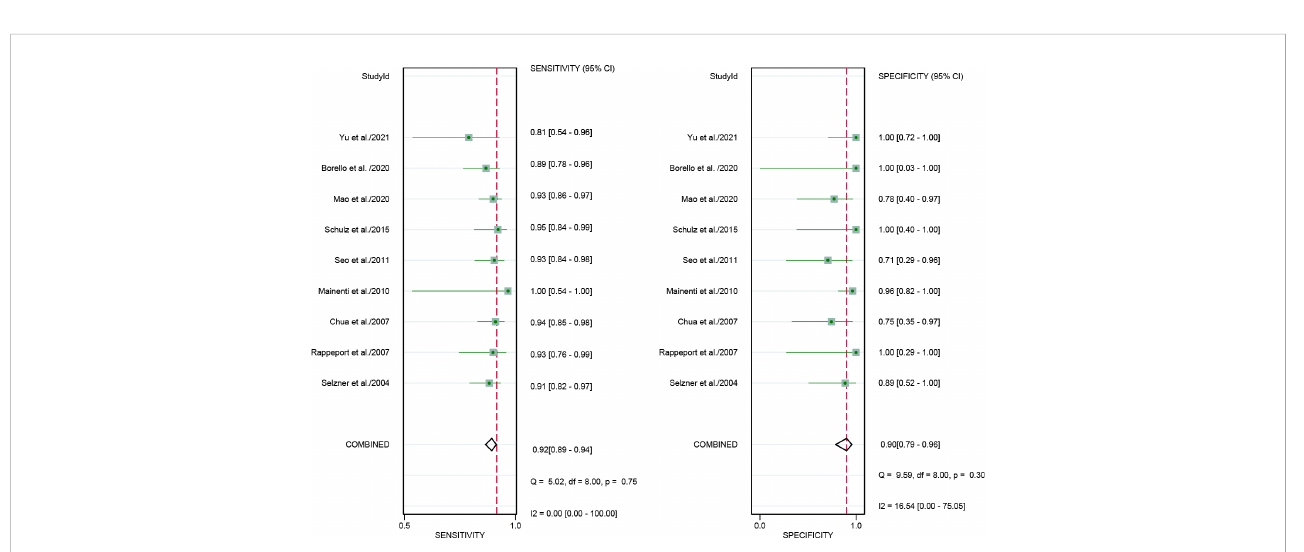
FIGURE 6 Forest plots of the combined [18F]FDG PET/CT sensitivity and speci fi city in patient-based analysis for colorectal liver metastasis. Squares denoted the sensitivity and speci fi city in each study, while horizontal bars indicated the 95% con fi dence interval.